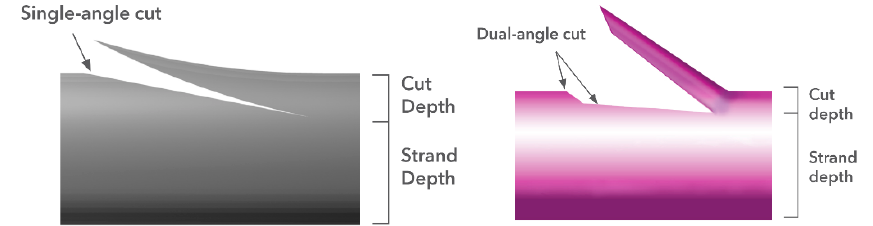
Figure 12. Di ff erent barb design for V-Loc TM suture. Left: single angle cut barb. Right: dual angle cut barb [32]. cut barb